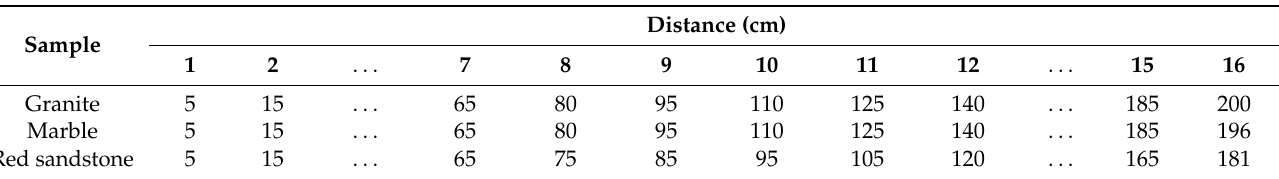
Table 2. Signal collection sensor layout